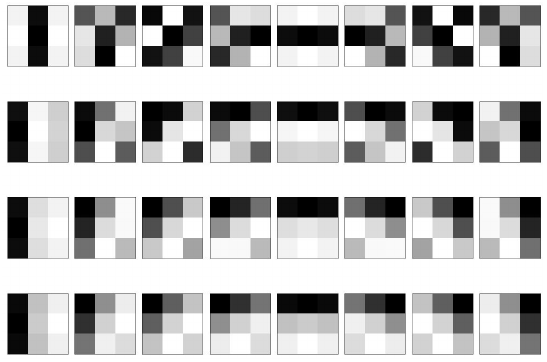
Figure 2. The filters of the Gabor transform.